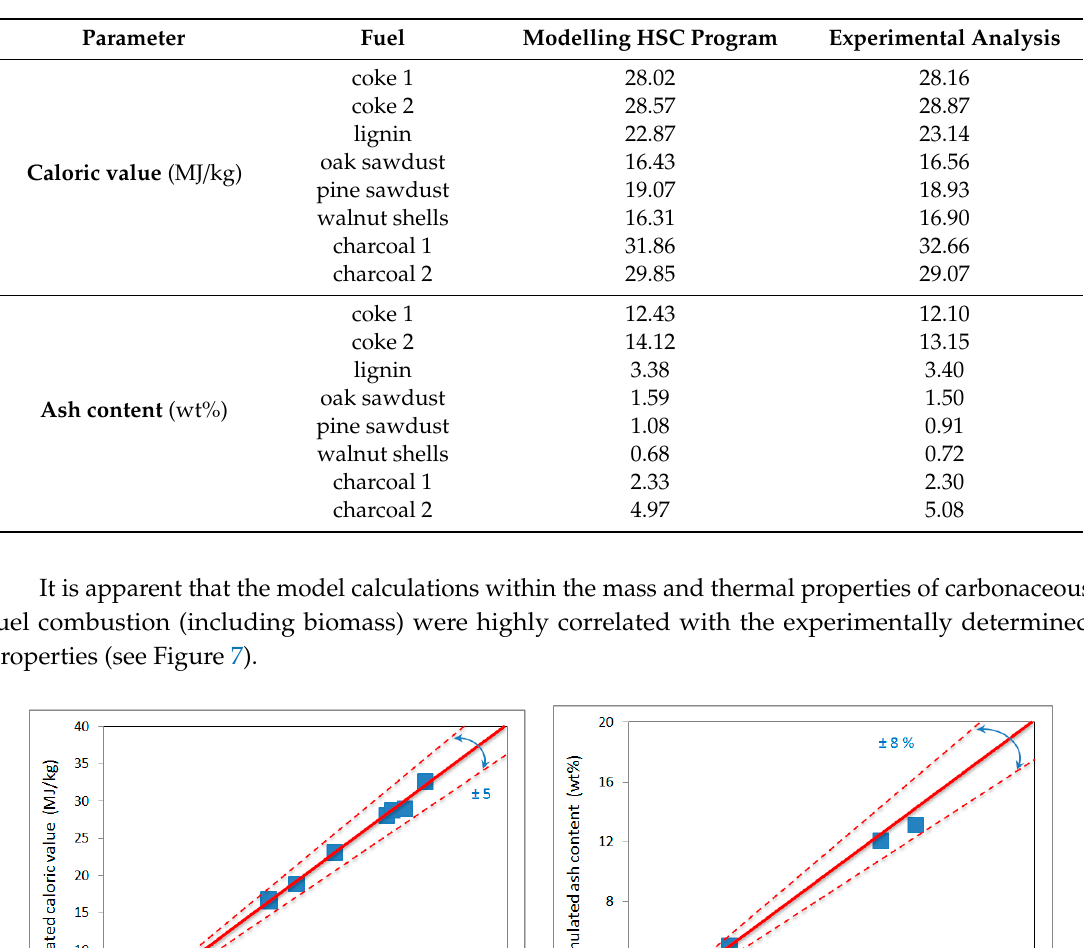
Table 6. Parameters of fuel combustion.